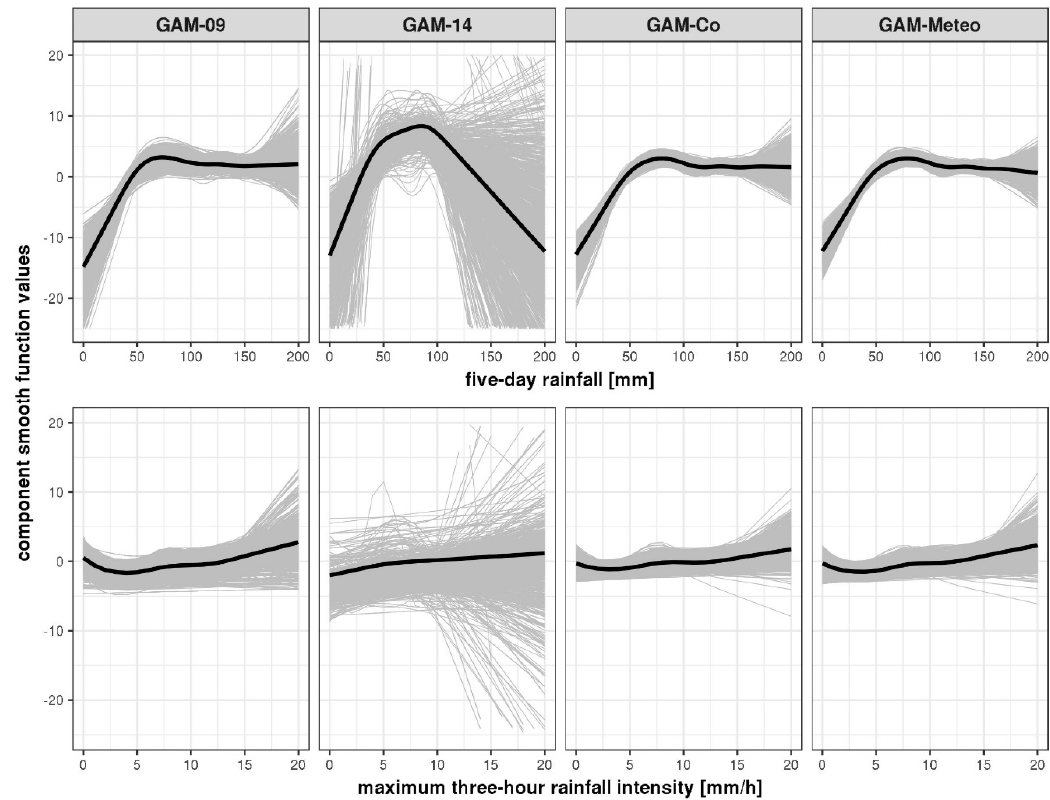
Figure 6. Relationship between landslide occurrence and metrological variables visualized with CSF plots. The relationships on the linear predictor scale (logit scale, centered) were extracted from all SpCV models (grey lines) and averaged (black line).